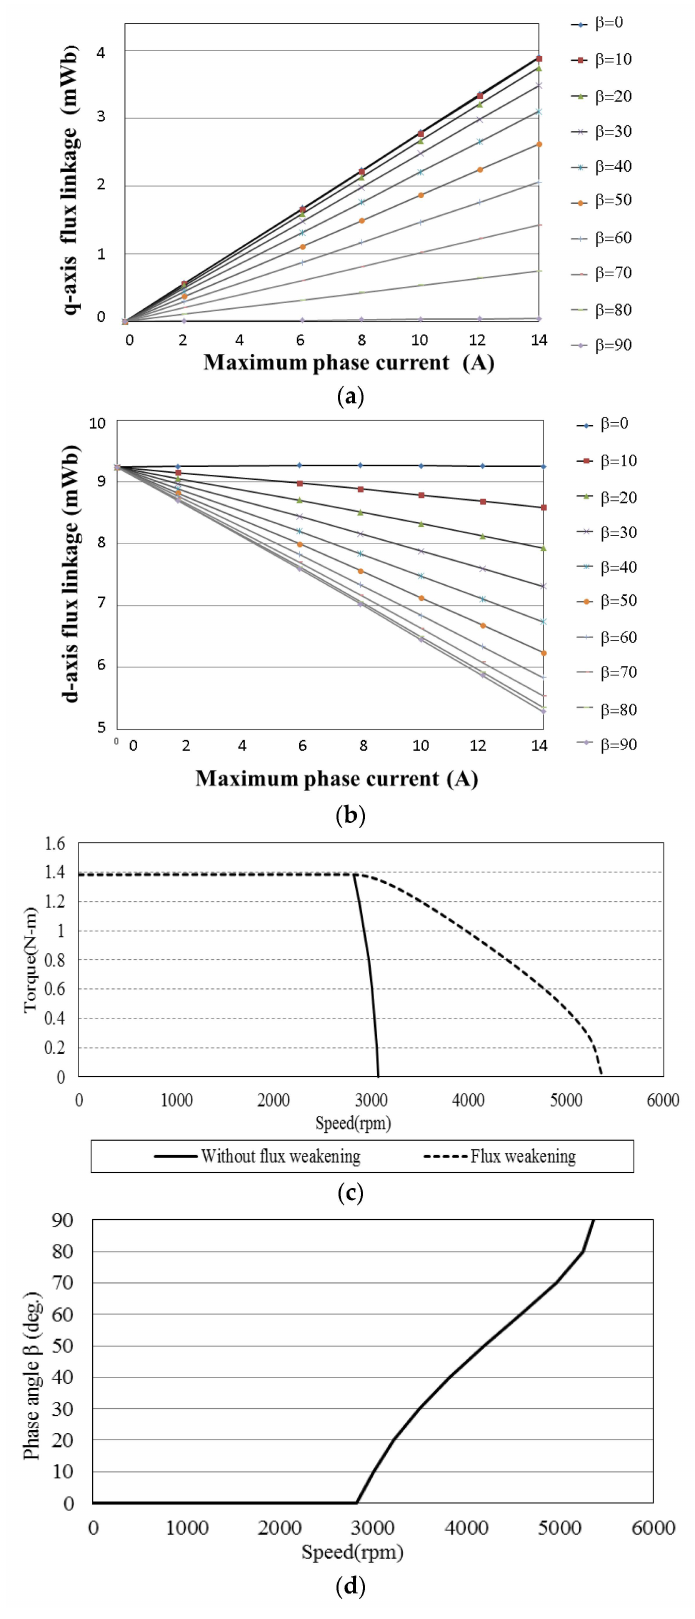
Figure 7. ( a ) The q-axis flux linkages; ( b ) d-axis flux linkages; ( c ) TN curves with and without the flux-weakening control; and ( d ) the corresponding current lead angle against the speed with a flux-weakening